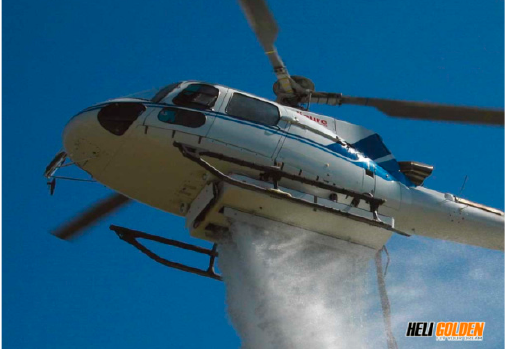
Figure 1. H125 firefighting helicopter and Isolair Eliminator II belly firefighting tank (from